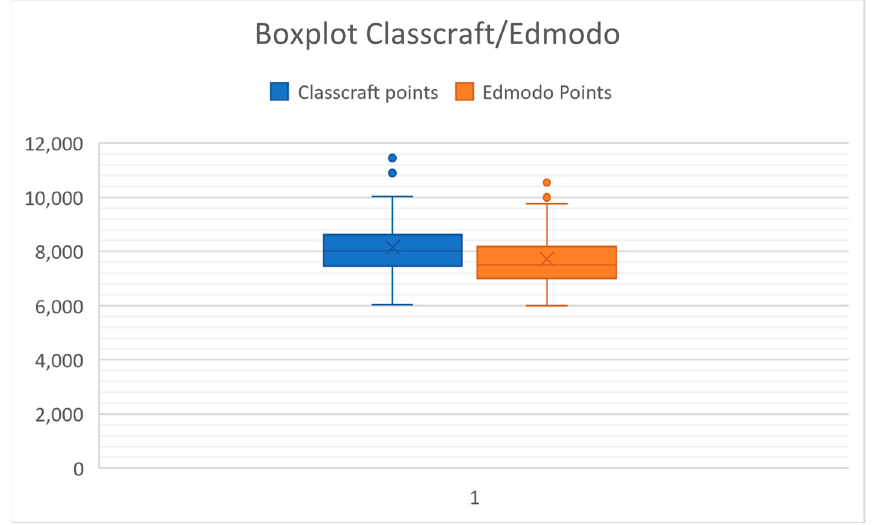
Figure 22. Boxplot obtained with points in Edmodo and Classcraft by students.